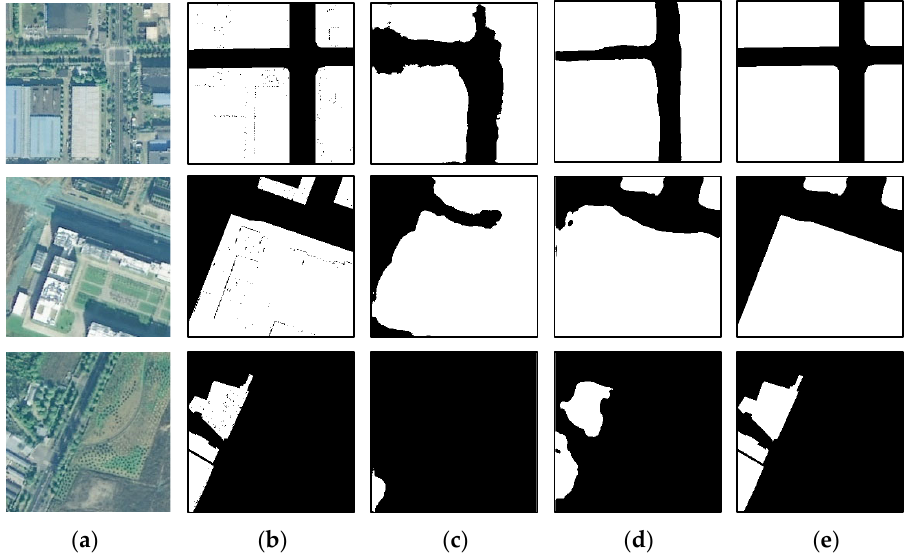
Figure 17. Comparison of ablation visualization results on the Beijing Huairou district land survey dataset, ( a ) 2019 image, ( b ) 2019 ground truth, ( c ) baseline, ( d ) baseline + CycleGAN, ( e ) baseline + CycleGAN + the post ‐ processing update strategy.